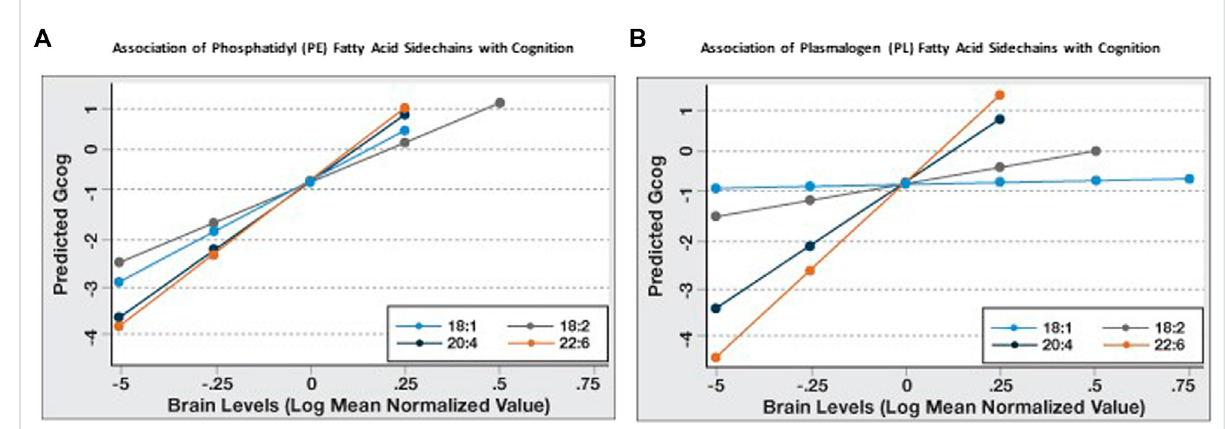
FIGURE 1 Sn-2 fatty acid sidechain-speci fi c associations of phosphatidyl (PE) and plasmalogen ethanolamines (PL) with cognitive function (Gcog). Regression analyses were conducted with Gcog as the outcome variable and respective phospholipid species with different sn-2 fatty acid side chains as the independent variable. Four separate models for each phospholipid species, adjusted for age, sex and education, were constructed and postestimationpredictedvalueoftheoutcomevariablebybrainlevelsofrespectivephospholipidwereplottedinasinglegraphforcomparison. (A) Effect of phosphatidyl ethanolamine (PE) species with different sn-2 fatty acid side chains on cognition; (B) Effect of plasmalogen ethanolamine (PL) species with different sn-2 fatty acid side chains on cognition.